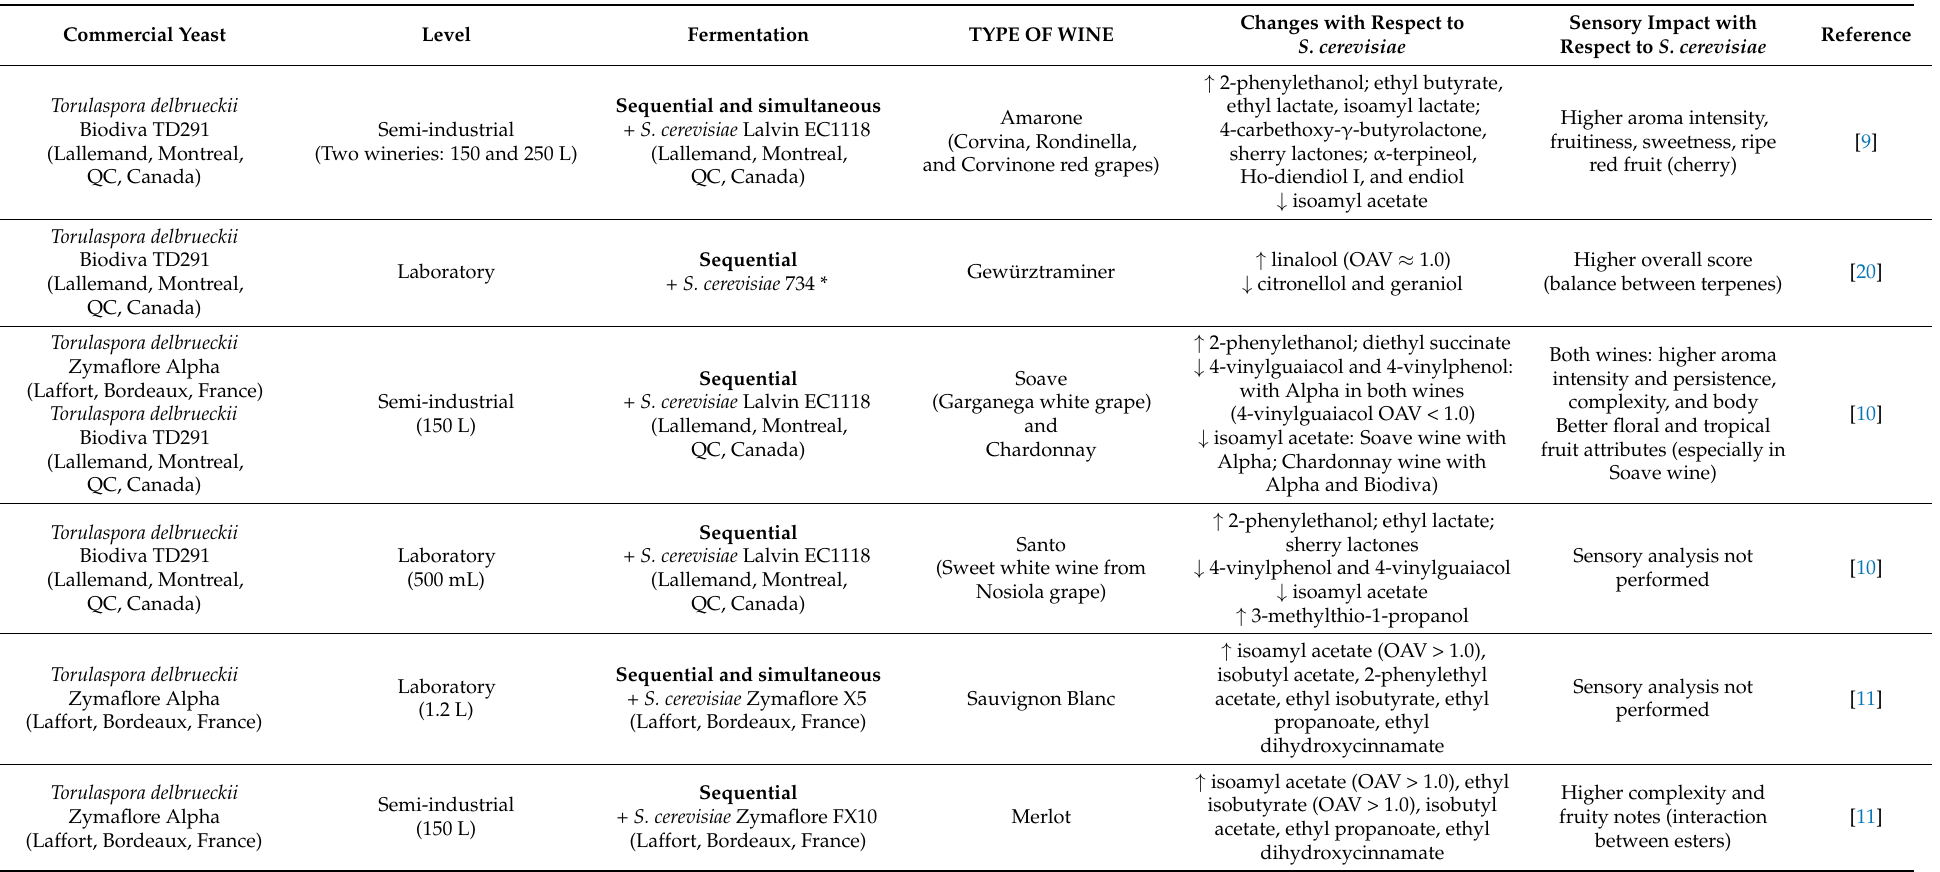
Table 2. Main changes produced by commercial non- Saccharomyces yeasts in the synthesis of metabolites, with their impact on the composition and sensory profile of the wine (increase ↑ or decrease ↓ in the content of each